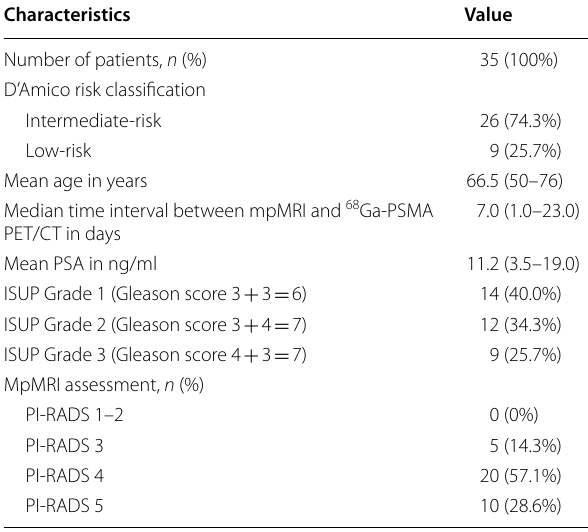
Table 3 Diagnostic results of mpMRI and 68 Ga-PSMA PET/CT on high-risk prostate cancer patients